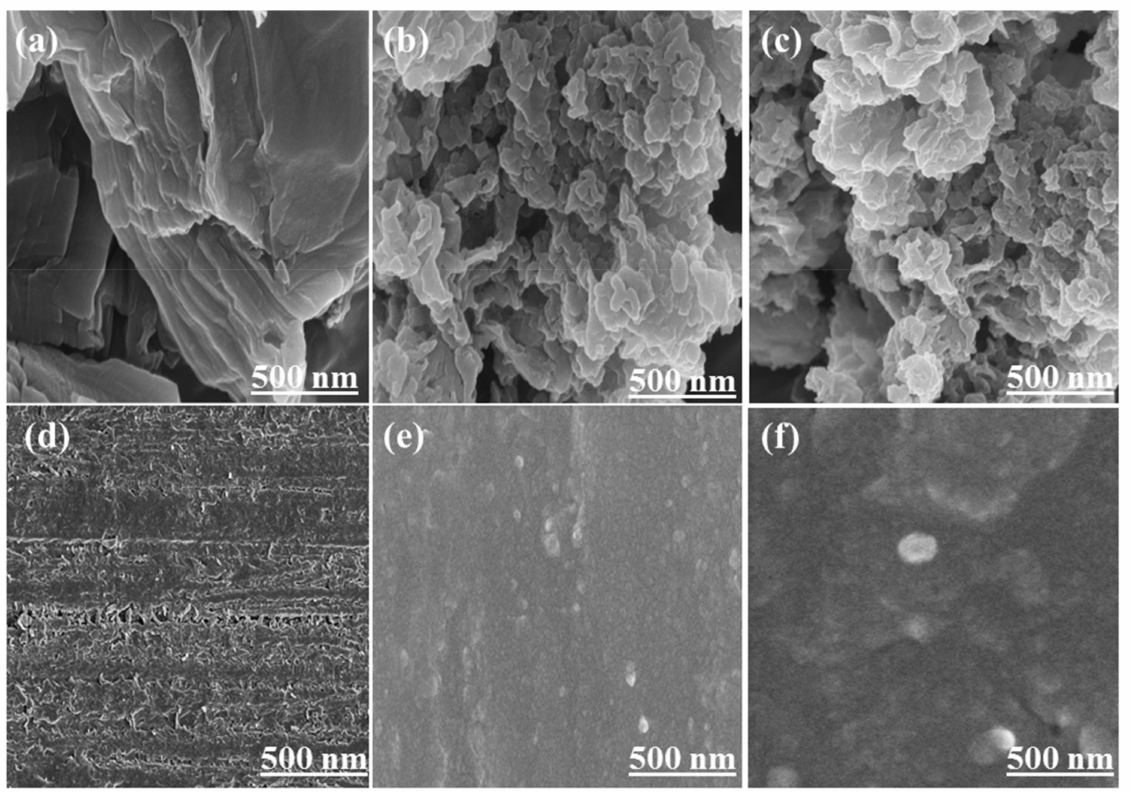
Figure 5. FESEM images of ( a ) pristine GO ( b ) MDA-B-GO ( c ) BDM-B-GO ( d ) neat epoxy. ( e )